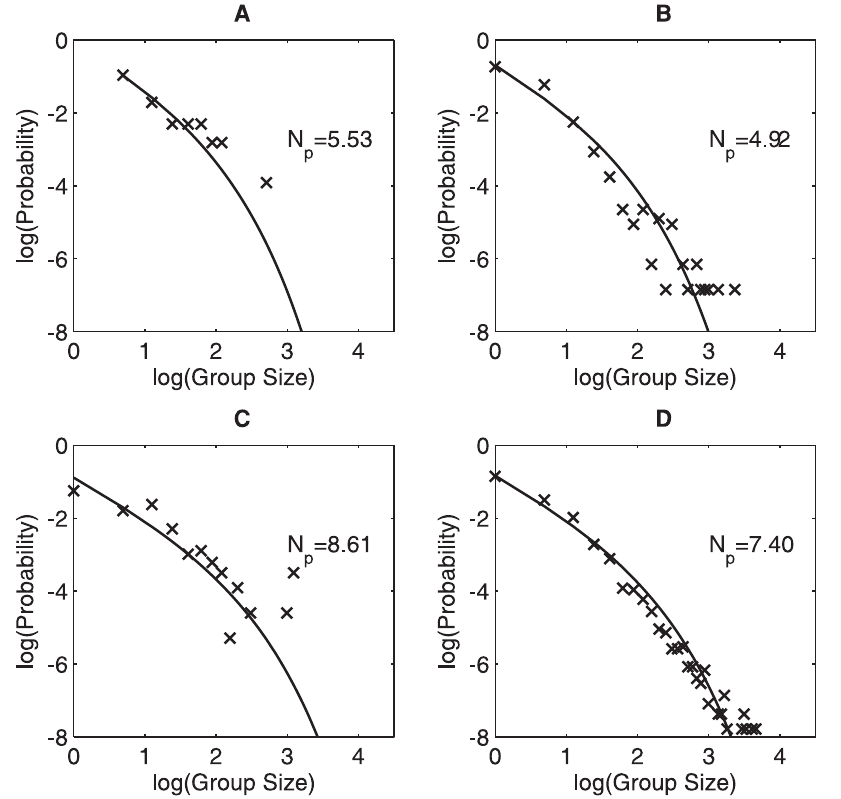
Figure 4. Effect of behavior on group–size distribution. Group-size distribution for individuals who are fighting (number of observations, n =50) (A), flying ( n =942) (B), foraging ( n =199) (C) and perching ( n =4797) (D). Fighting distributions are adjusted to account for the fact that group sizes must be equal to or greater than 2.